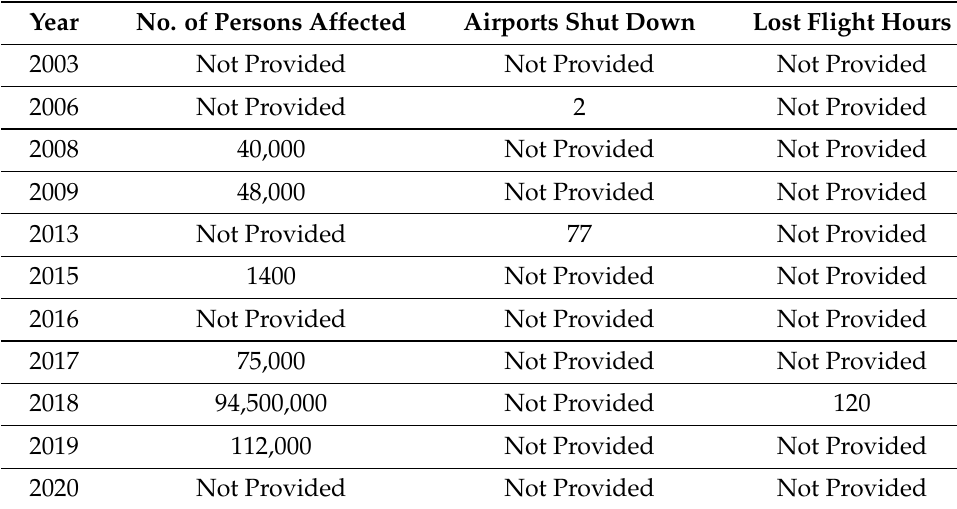
Table 3. Cost of Cyber-Attacks in the Aviation Industry Per Year.